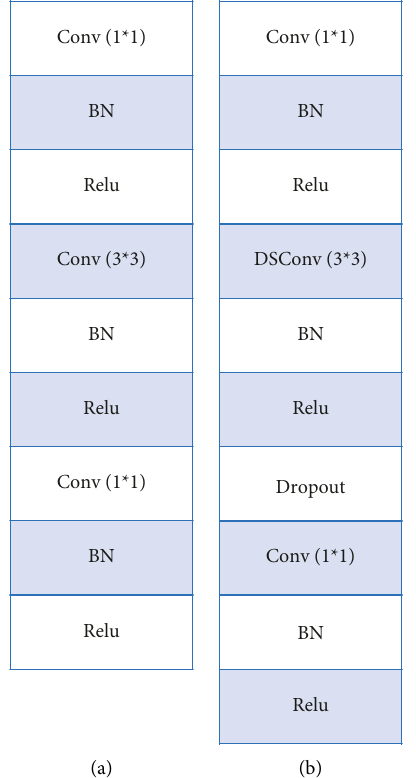
Figure 4: Structure comparison before and after resnet_2b improvement. (a) Before improvement. (b) After improvement.